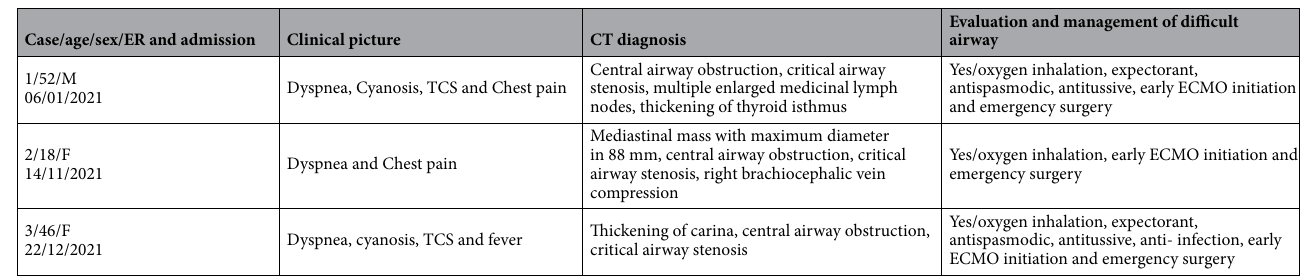
Table 1. Clinical characteristics and treatments of patients. ER, emergency room; TCS, three concave sign; CT, computed tomography; ECMO, extracorporeal membrane